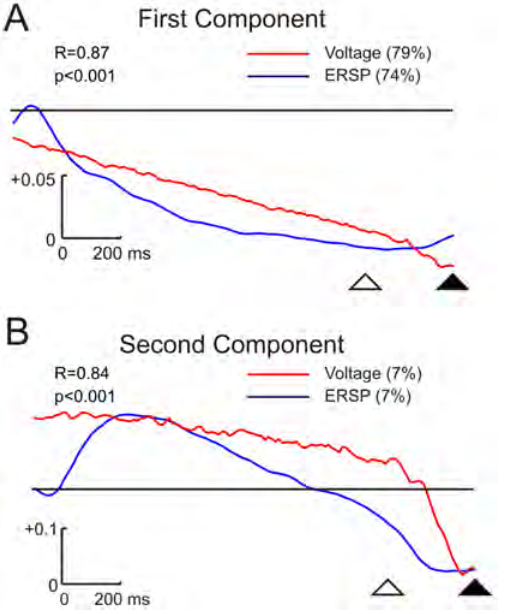
Figure 8. Principal component analysis loading factors ob- tained from voltage and event-related spectral power (ERSP) values. A and B show the temporal evolution of the loading factors of the first and second components, respectively. The explained variance is indicated between parentheses. The correlation coefficient (R) between voltage (red line) and ERSP (blue line) loading factor components and its statistical significance (p) are shown in each figure. The open and filled triangles indicate the end of the instructive and gap periods, respectively. Calibrations are indicated.